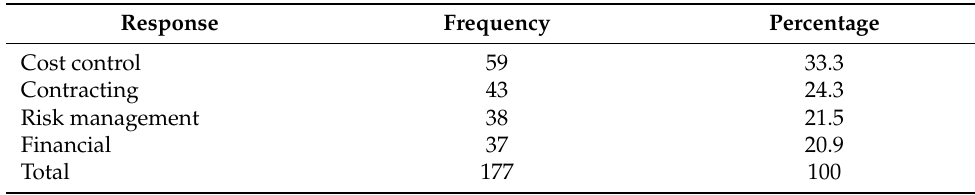
Table 2. Total responses by